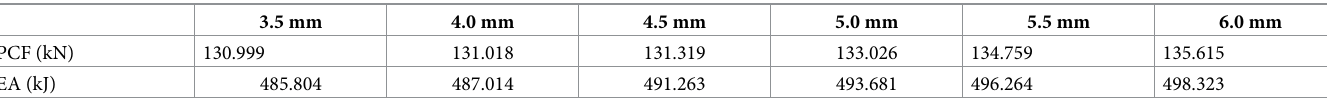
Table 1. Mesh convergence study